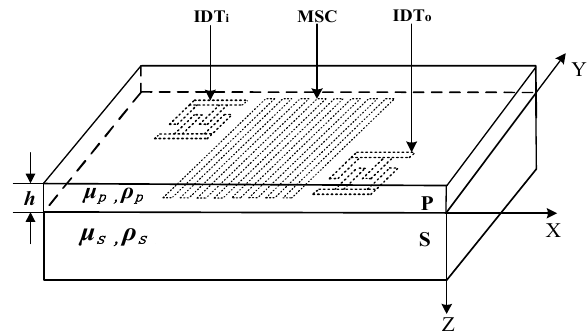
Figure 1. Schematic diagram of the Love wave humidity sensor.